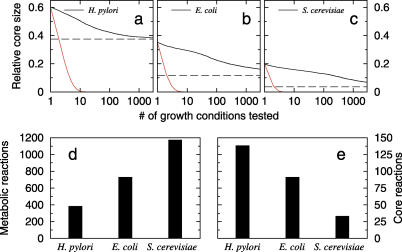
The Emergence of the Metabolic Core(A–C) The average relative size of the number of reactions that are always active as a function of the number of sampled conditions (black line) for (A) H. pylori, (B) E. coli, and (C) S. cerevisiae. As the number of conditions increases, the curve converges to a constant denoted by the dashed line, identifying the metabolic core of an organism. The red line denotes the number of reactions that are always active if activity is randomly distributed in the metabolic network. The fact that it converges to zero indicates that the real core represents a collective network effect, forcing a group of reactions to be active in all conditions.(D and E) The number of metabolic reactions (D) and the number of metabolic core reactions (E) in the three studied organisms.